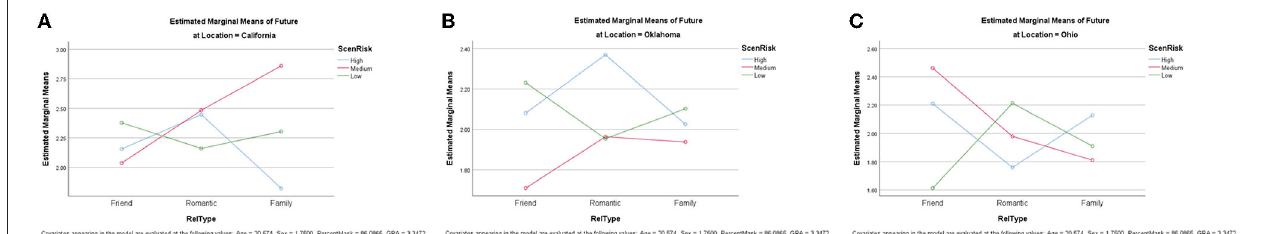
FIGURE 5 | (A–C) Three-way interaction between risk level, type of relationship, and location of data collection to predict reported perceived future relationship implications of an event invitation refusal during the COVID-19